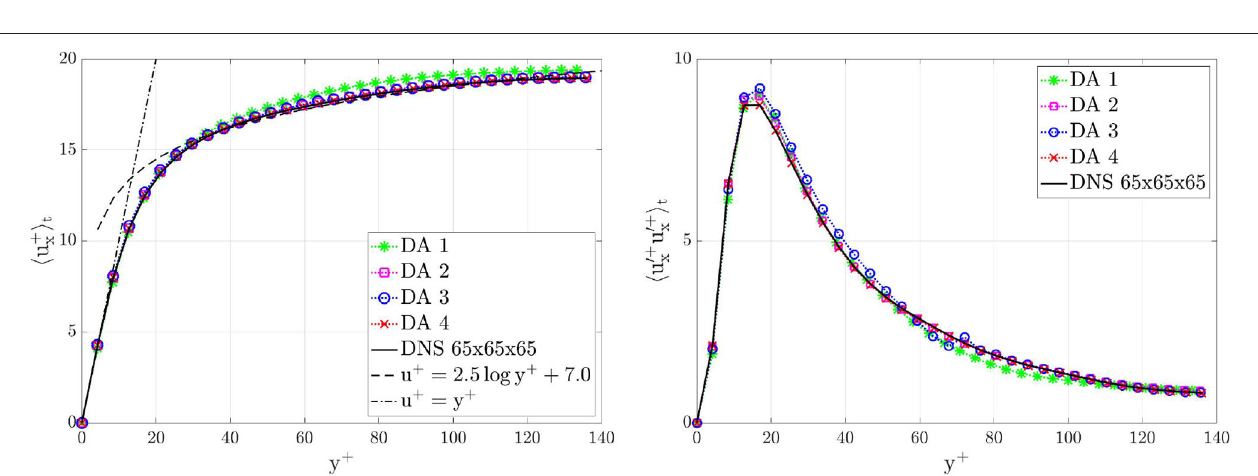
FIGURE 9 | Turbulent channel flow: comparison between DA predictions and ground truth on a line parallel to the y -axis and centered in the z -direction, i.e., z = π h , for x = 3 π h . Left: stream-wise mean velocity profiles h u x ( x = 3 π h , y , z = π h , t ) i t . Right: RSS profiles h u ′ x ( x = 3 π h , y , z = π h , t ) u ′ x ( x = 3 π h , y , z = π h , t ) i t . Results are plotted in wall units and are shown for the bottom half part of the channel, i.e., y ≤ h